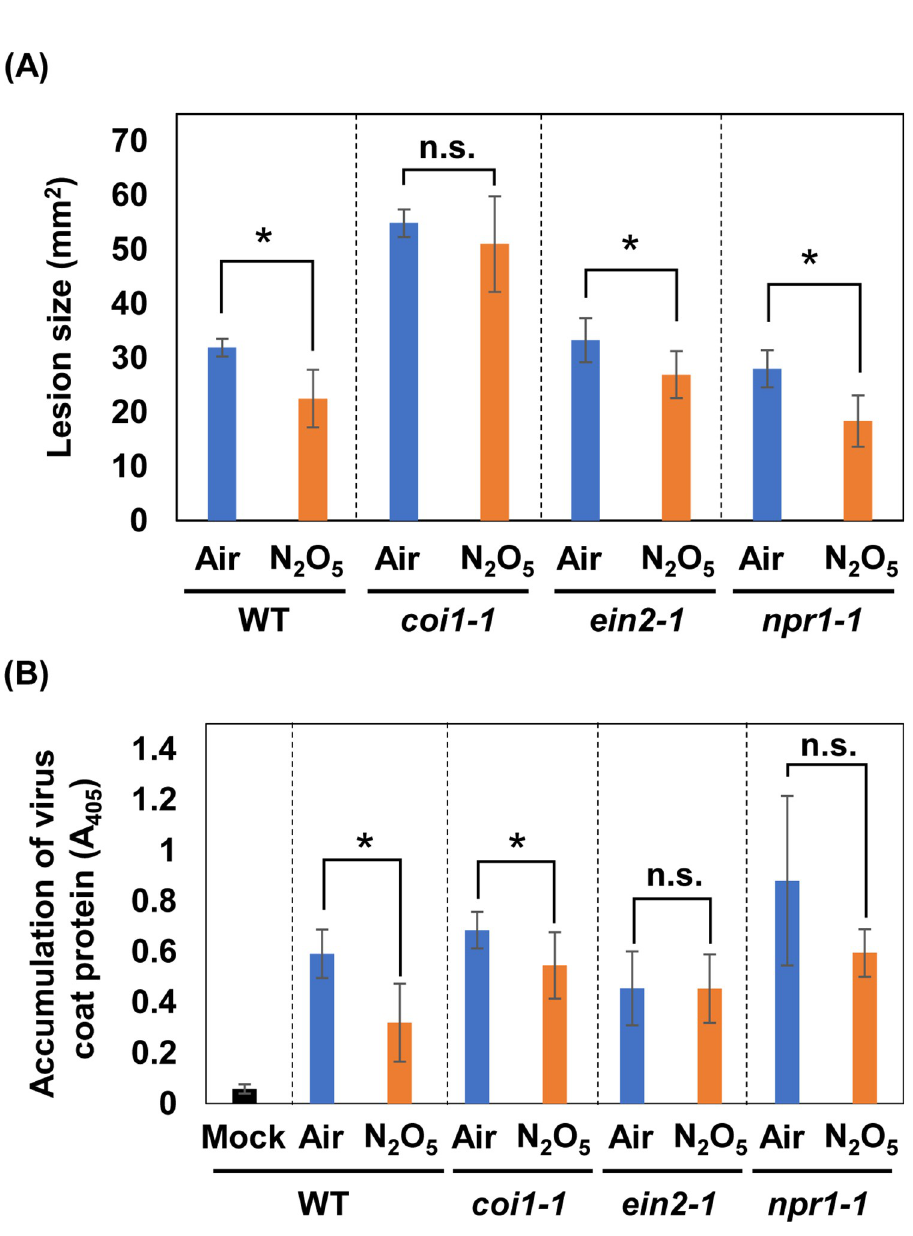
Fig 7. Resistance induced by N 2 O 5 -gas against Botrytis cinerea and CMV in Arabidopsis phytohormone signaling mutants. (A) The areas of the lesions at 2 days after B . cinerea inoculation were measured and the mean ( ± standard deviation) is shown. Asterisks denote significant differences (Student’s t -test, n = 9, P < 0.05). (B) Two days after CMV (Y) inoculation, the inoculated leaves were harvested and subjected to ELISA. Asterisks denote significant differences (Student’s t -test, n = 6, P < 0.05). n.s.: not